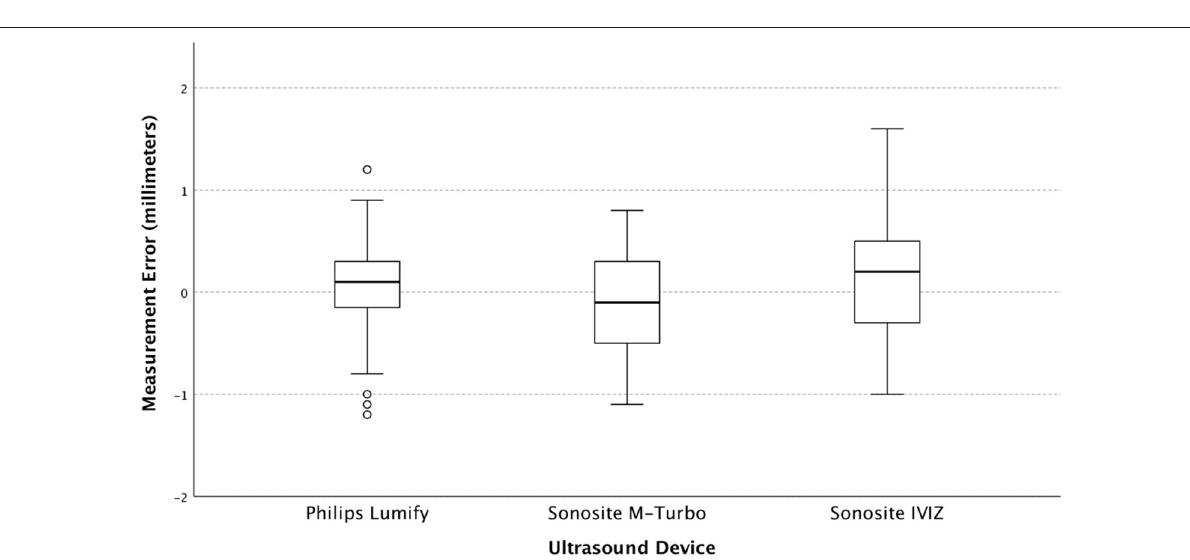
FIGURE 3 | The Box and whisker plot of measurement error (individual observed values minus predicted) stratified by